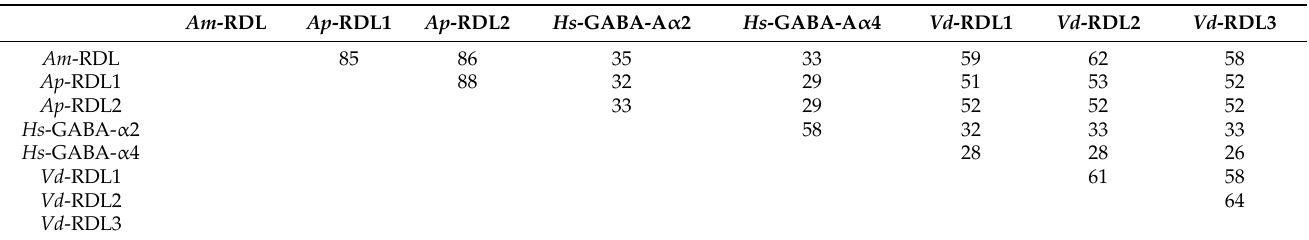
Table 1. Percentage of identity between the different RDL